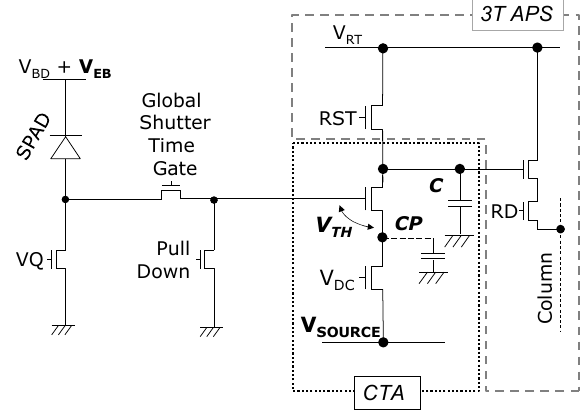
Figure 2. Charge transfer amplifier (CTA) analogue integrator pixel with active pixel sensor (APS) readout for global shutter or time-gated SPAD-based photon counting imaging.